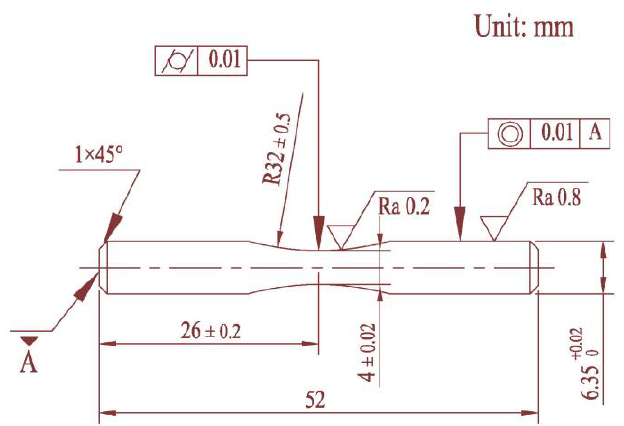
Figure 3. Specimen for tensile test and its dimensions.